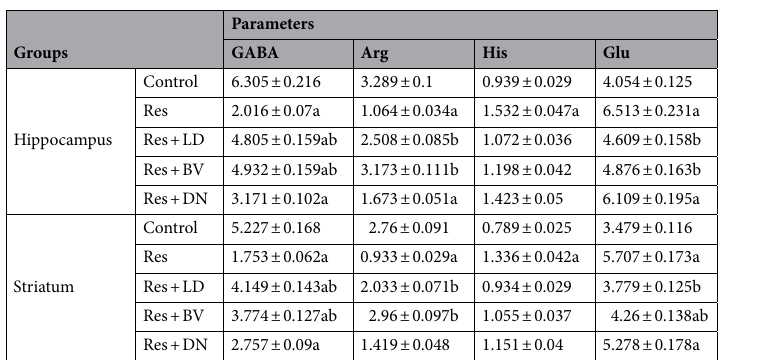
Table 2. Effect of L-Dopa, BV, and DA-nanoparticles on brain amino acids neurotransmitters in reserpine- treated rats. Data are expressed as Mean ± S.E. for 6-rats/group. a letter marks significant difference from control group at the same column with one-way ANOVA at P < 0.05. b letter marks significant difference from reserpine group at the same column with one-way ANOVA at P < 0.05. ab indicates significant difference from both control and reserpine-treated